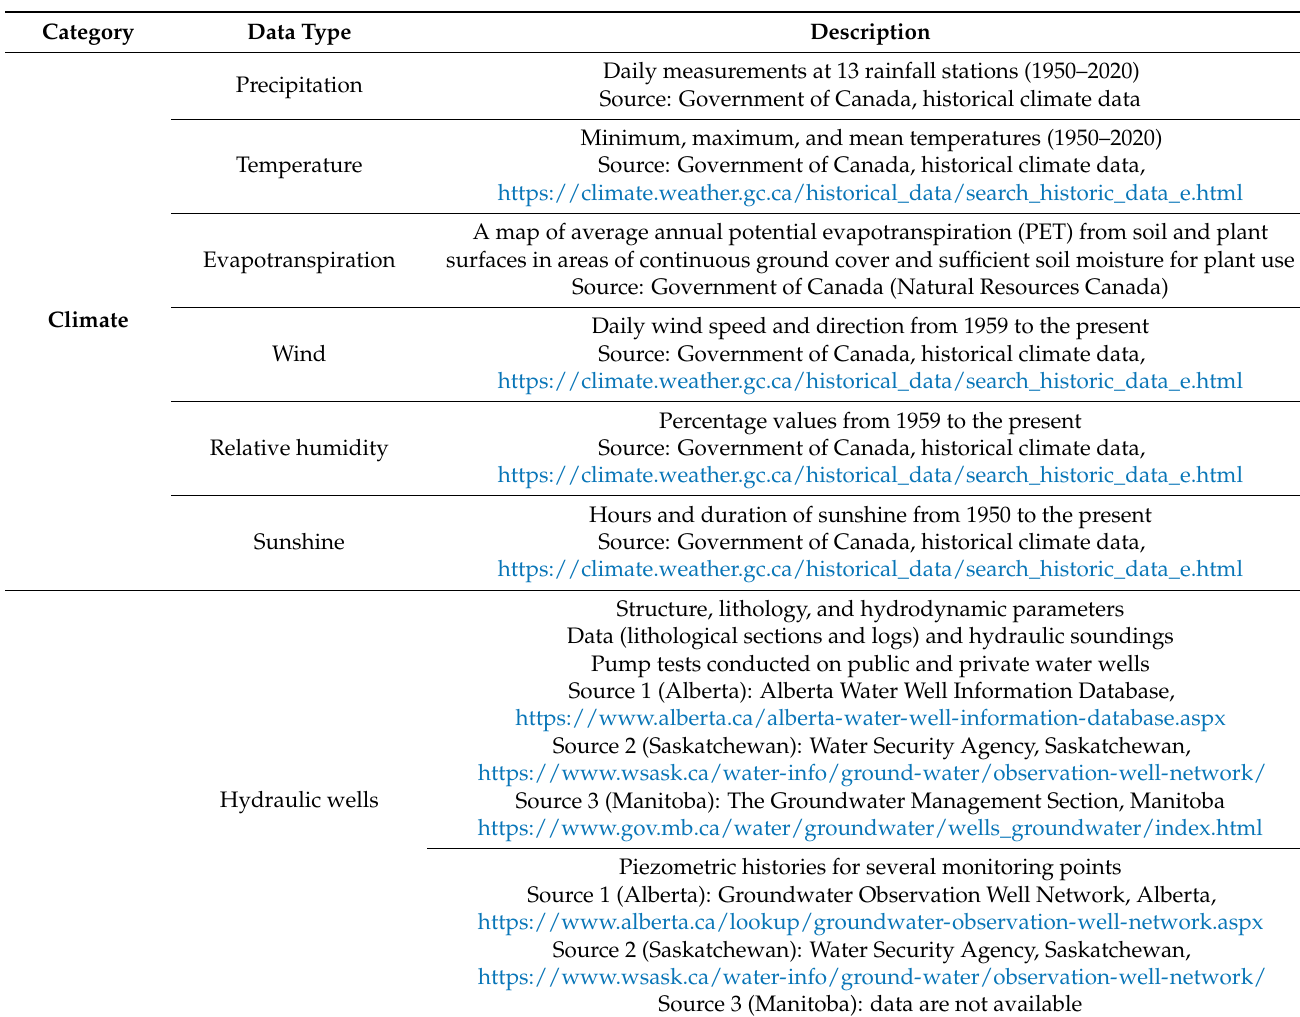
Table 1. Presentation of climatic, geological, and hydrogeological data and their sources. Note: n.d. = no date available. (access date: all the links was verified on the 3 March